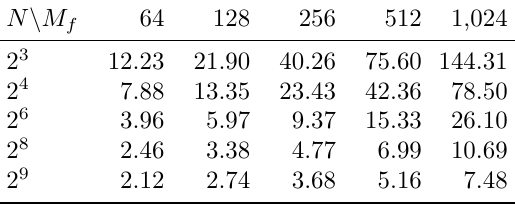
Table 7: Maximum load averages with various numbers of faulty signatures M f in different layers of N signatures.